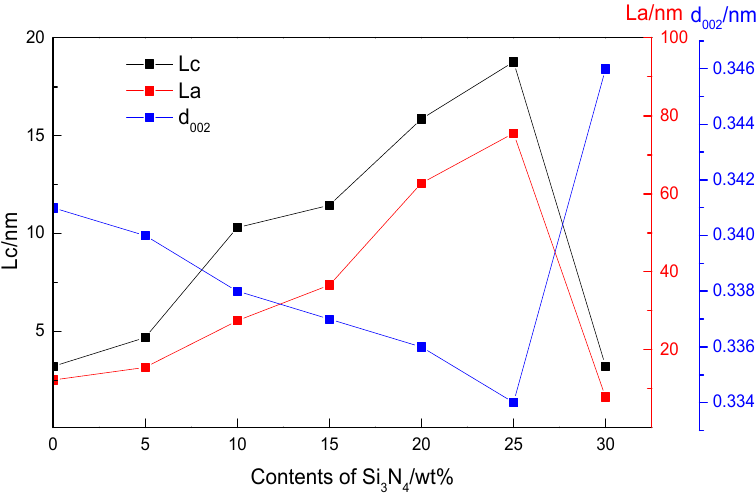
Figure 4. Crystalline parameters of h-BN with di ff erent Si 3 N 4 contents.